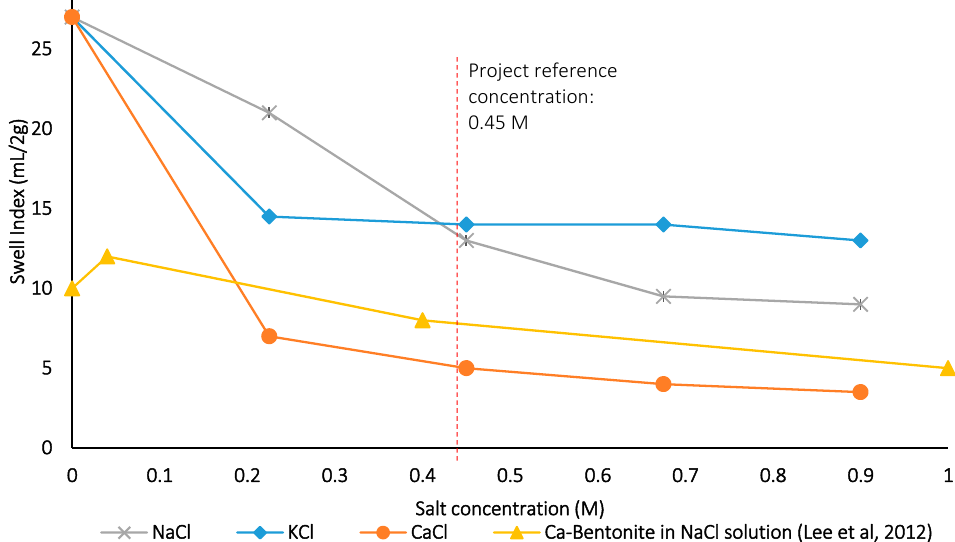
Figure 7. Swell index results for batch 1 tests (Ca-bentonite results after 19), dotted line highlighting the reference salinity concentration.